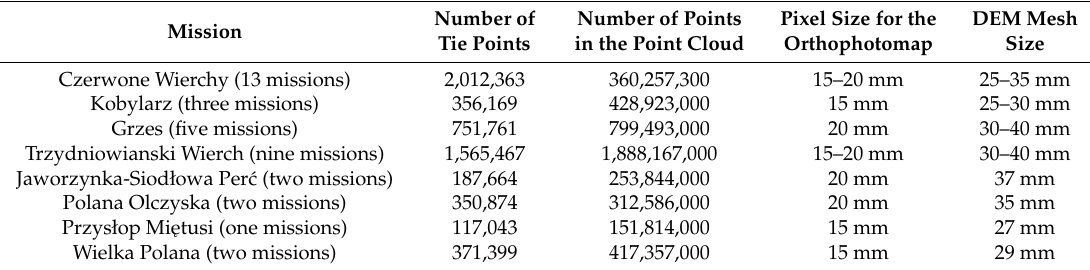
Table 4. The basic parameters of final products generated on the basis of photographs. Mission Number of Number of Points Tie Points in the Point Cloud